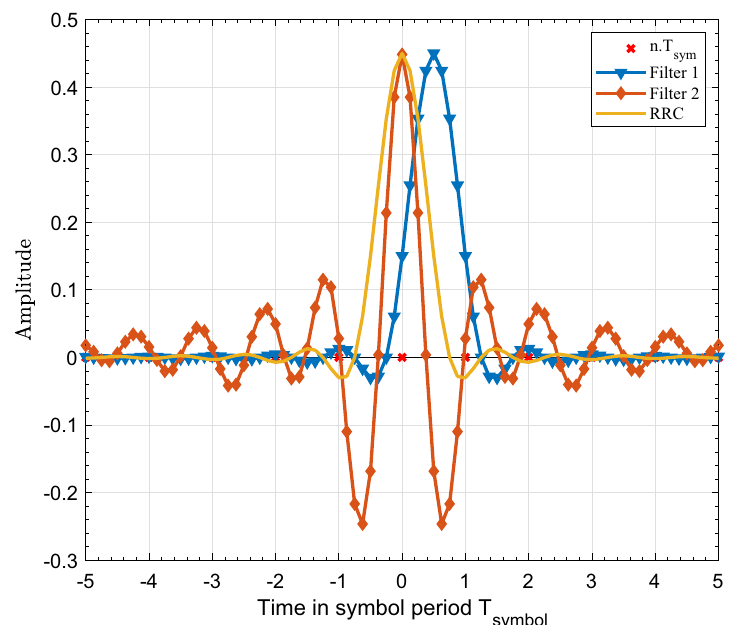
Fig. 4 Impulse response for the 2 designed IQ-FSIM filters and RRC pulse shaping filter having same η = 10 and (cid:31) = 8